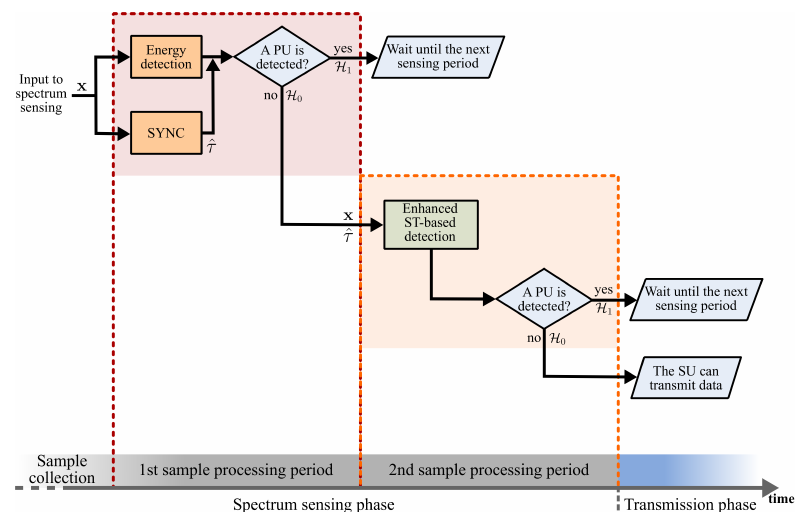
Figure 2. Block diagram of the proposed ST combined approach for a reduced phase (SCAR-Phase) of spectrum